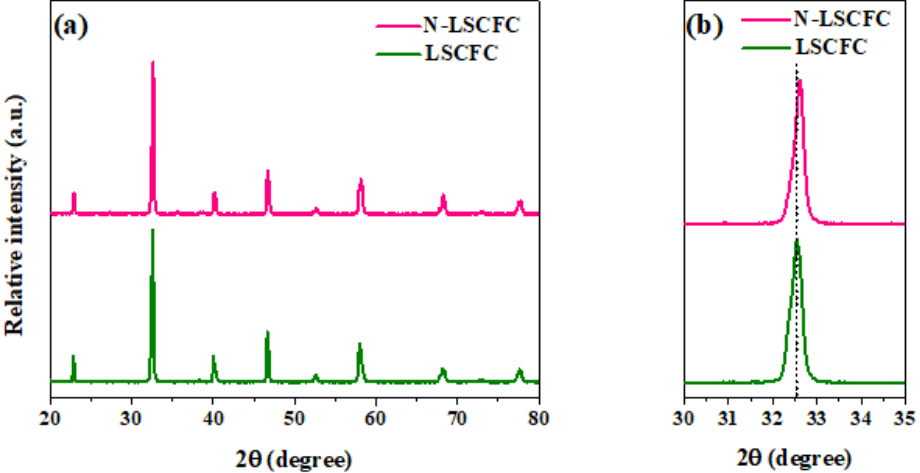
Figure 1. Room temperature XRD patterns. ( a ) LSCFC and N-LSCFC perovskites sintered at 1250 °C in air, and ( b ) magnification peak located at 32–33°.